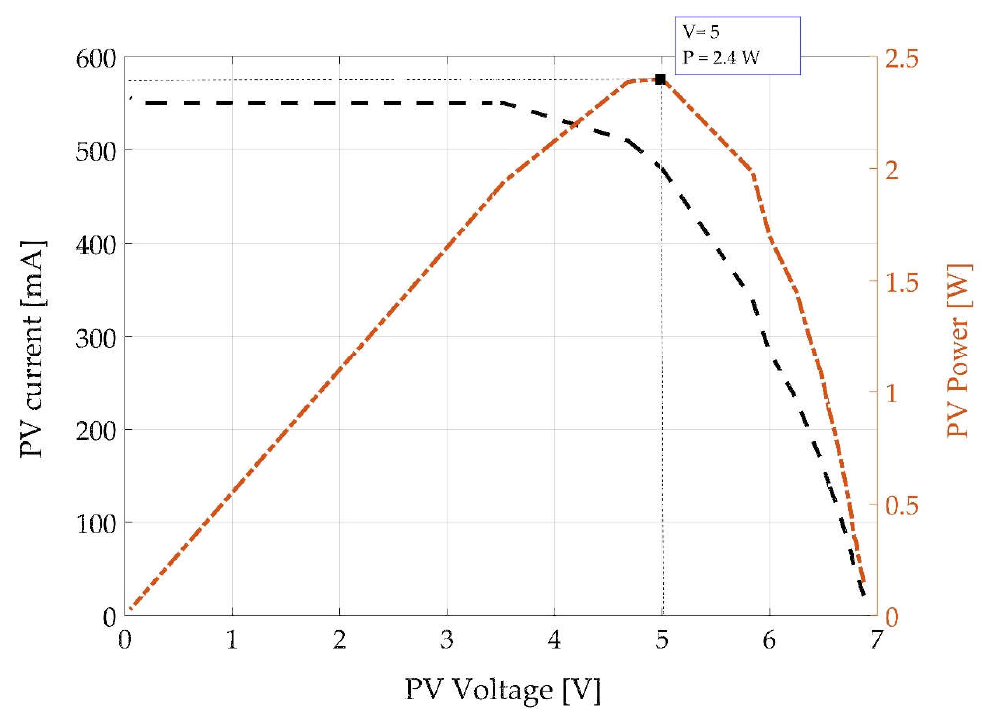
Figure 3. Solar panel characteristics.